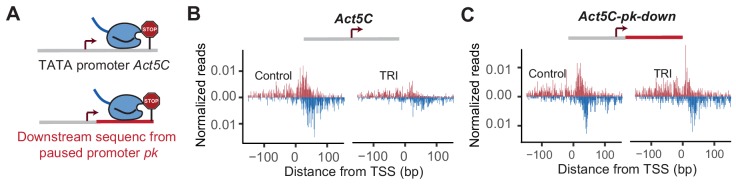
Downstream promoter sequences influences Pol II pausing at Act5C.Pol II ChIP-nexus profile at Act5C and Act5C-pk-down fusion promoters under control condition and after 5 min Triptolide (TRI) treatment.